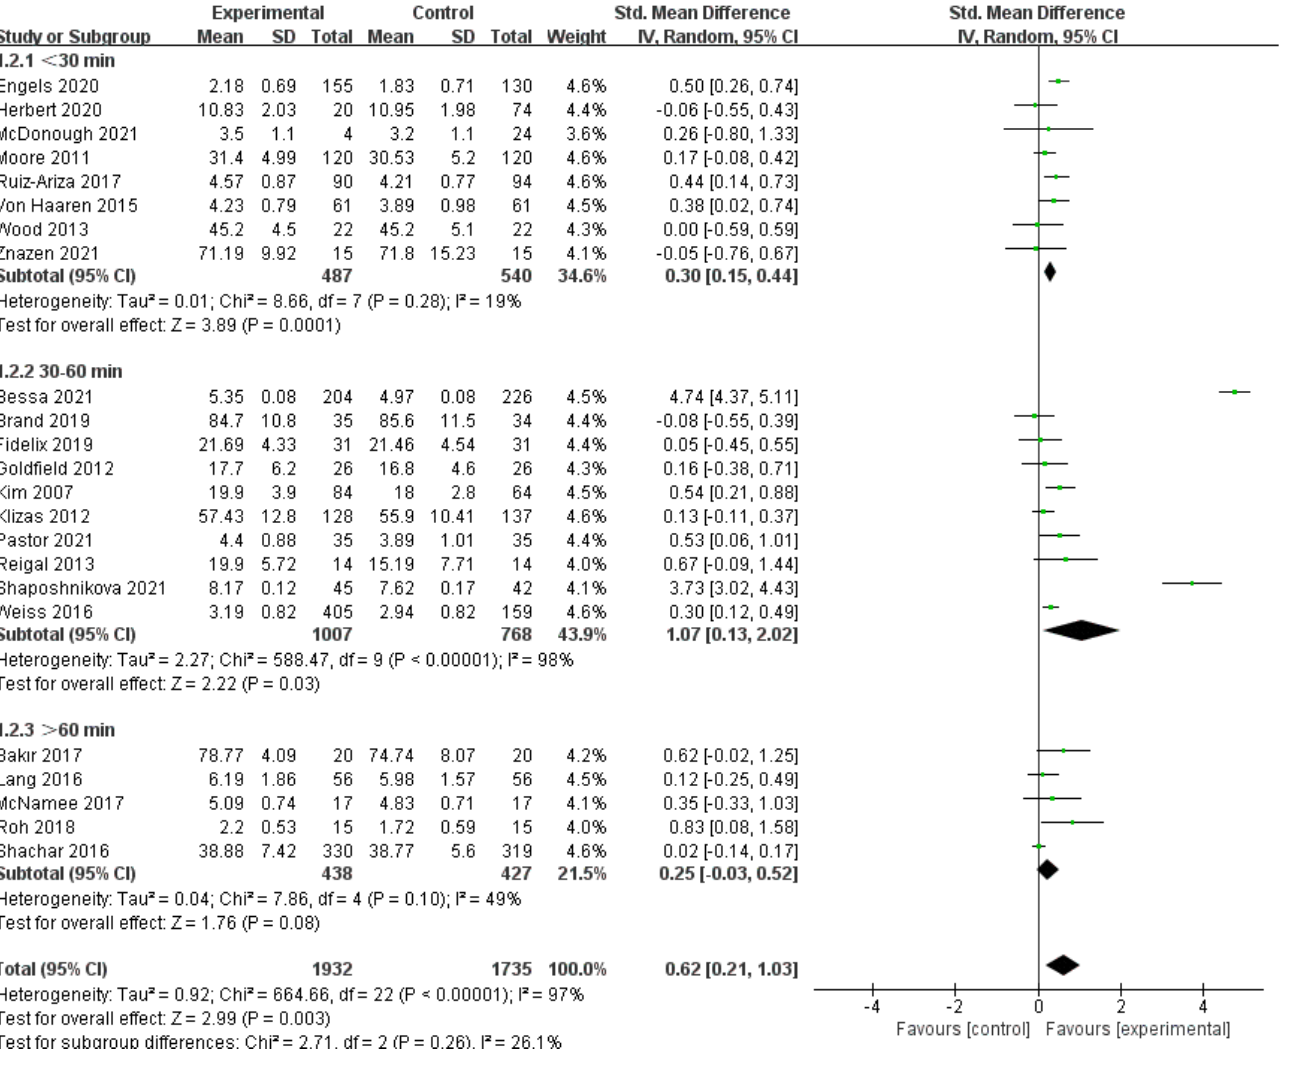
Figure 5. Exercise Duration Subgroup of the Association between PA and Positive Emotions in Children and Adolescents [30 – 44,46 – 53].